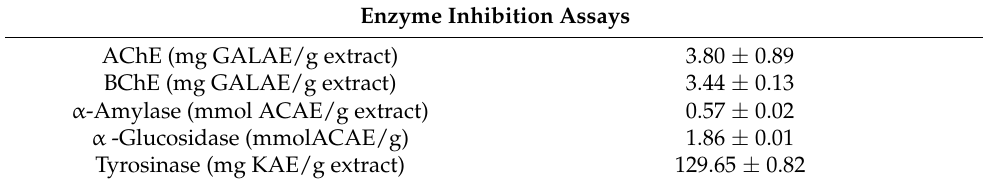
Table 4. Enzyme inhibition activities of H. crispum .